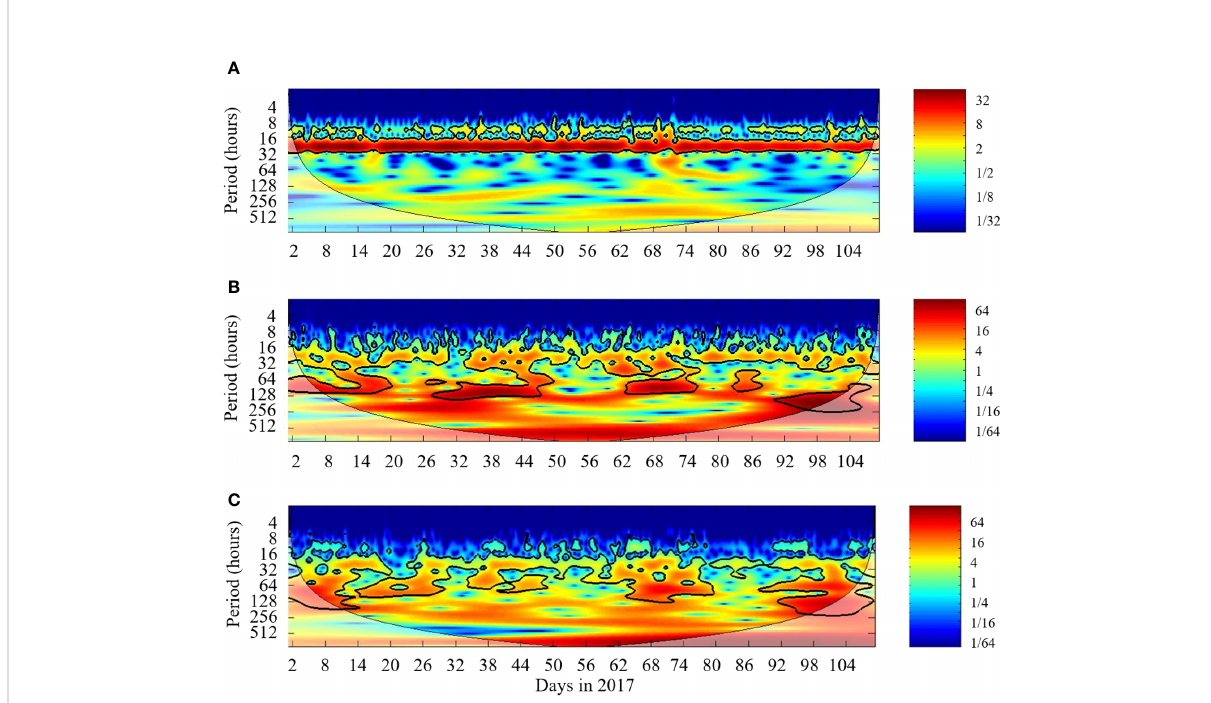
FIGURE 6 Wavelet power spectrum of CO 2 fl uxes (A) , windspeed (B) and water pressure anomaly (C) for the period spanning from January up to April 2017. The contours are for variance units. The 5% signi fi cance level against red noise is shown as a thick contour (cone of in fl uence). Blurred regions indicate values outside the cone of in fl uence. The 95% signi fi cance level is shown by heavy black contours. The horizontal scale represents the Julian days in January-April 2017